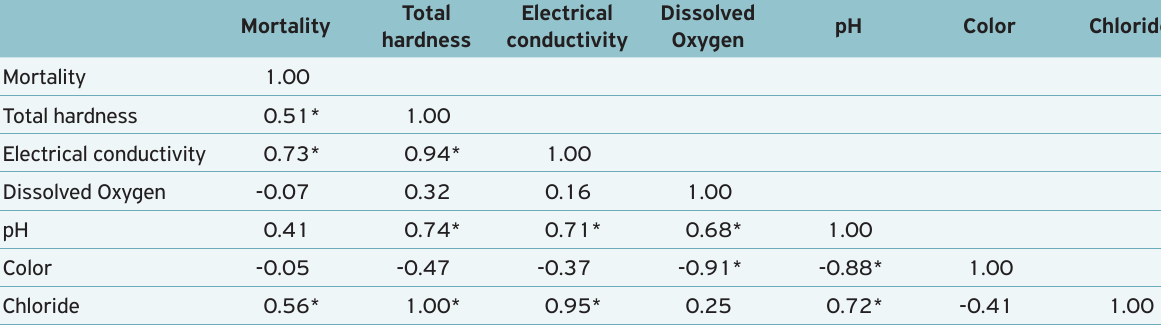
Table 3. Correlations of chemical parameters and toxicity in the River (all sites and seasons combined).